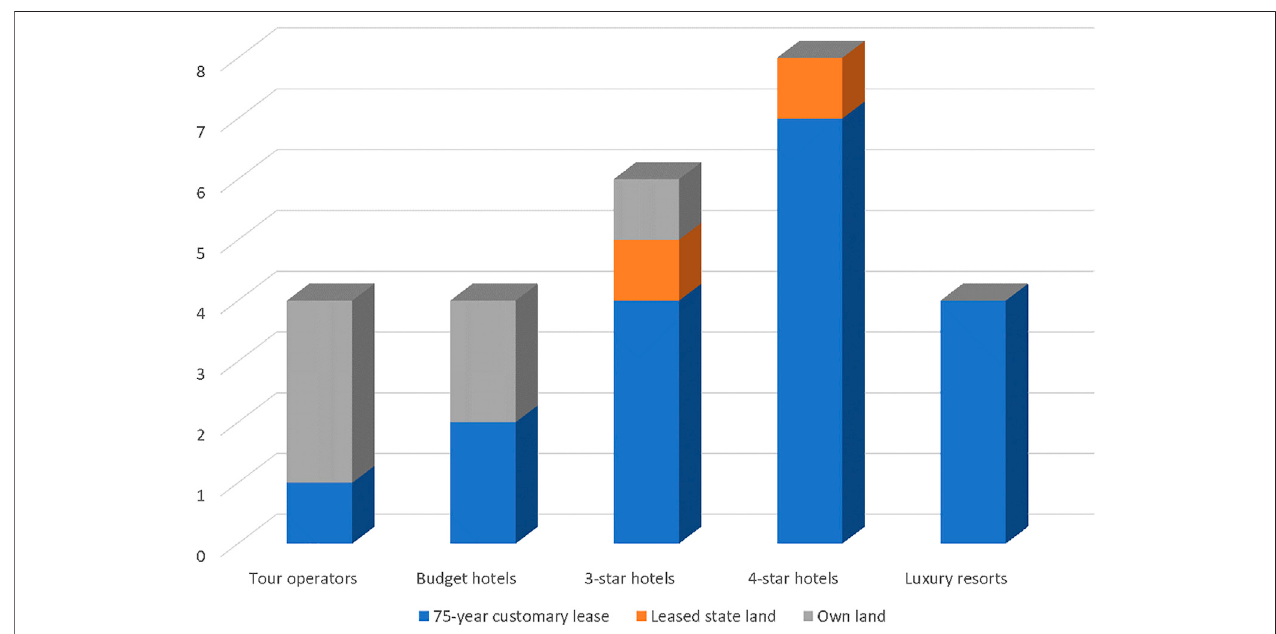
FIGURE 5 | Land tenure status of the surveyed tourism businesses. Source: Author ’ s own.